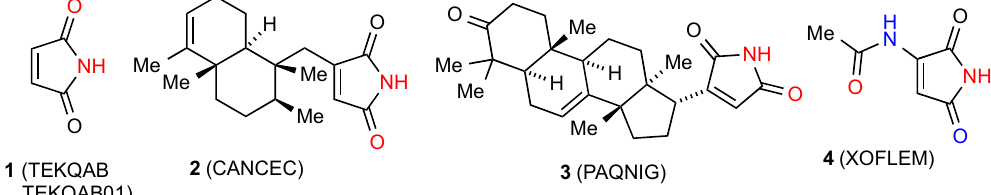
Figure 3. Maleimide and monosubstituted maleimides.